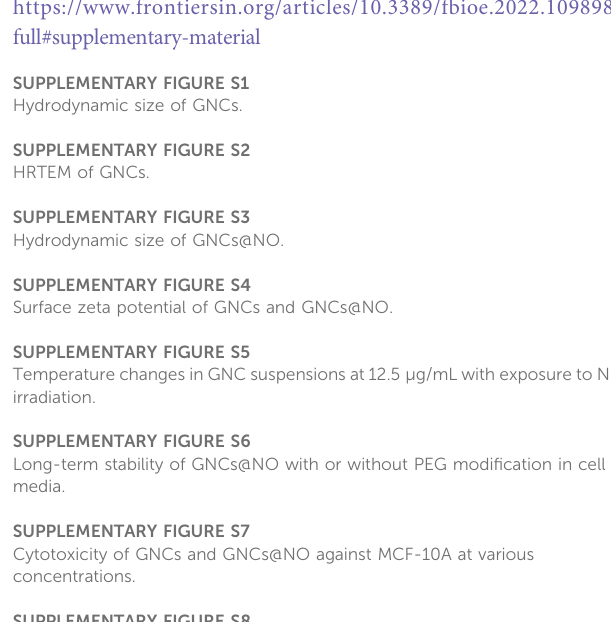
SUPPLEMENTARY FIGURE S1 Hydrodynamic size of GNCs. SUPPLEMENTARY FIGURE S2 HRTEM of GNCs. SUPPLEMENTARY FIGURE S3 Hydrodynamic size of GNCs@NO. SUPPLEMENTARY FIGURE S4 Surface zeta potential of GNCs and GNCs@NO. SUPPLEMENTARY FIGURE S5 Temperature changes in GNC suspensions at 12.5 μ g/mL with exposure to NIR irradiation. SUPPLEMENTARY FIGURE S6 Long-term stability of GNCs@NO with or without PEG modi fi cation in cell media. SUPPLEMENTARY FIGURE S7 Cytotoxicity of GNCs and GNCs@NO against MCF-10A at various concentrations. SUPPLEMENTARY FIGURE S8 Quantitative analysis of the cellular internalization of GNCs and GNCs@NO in MCF-7